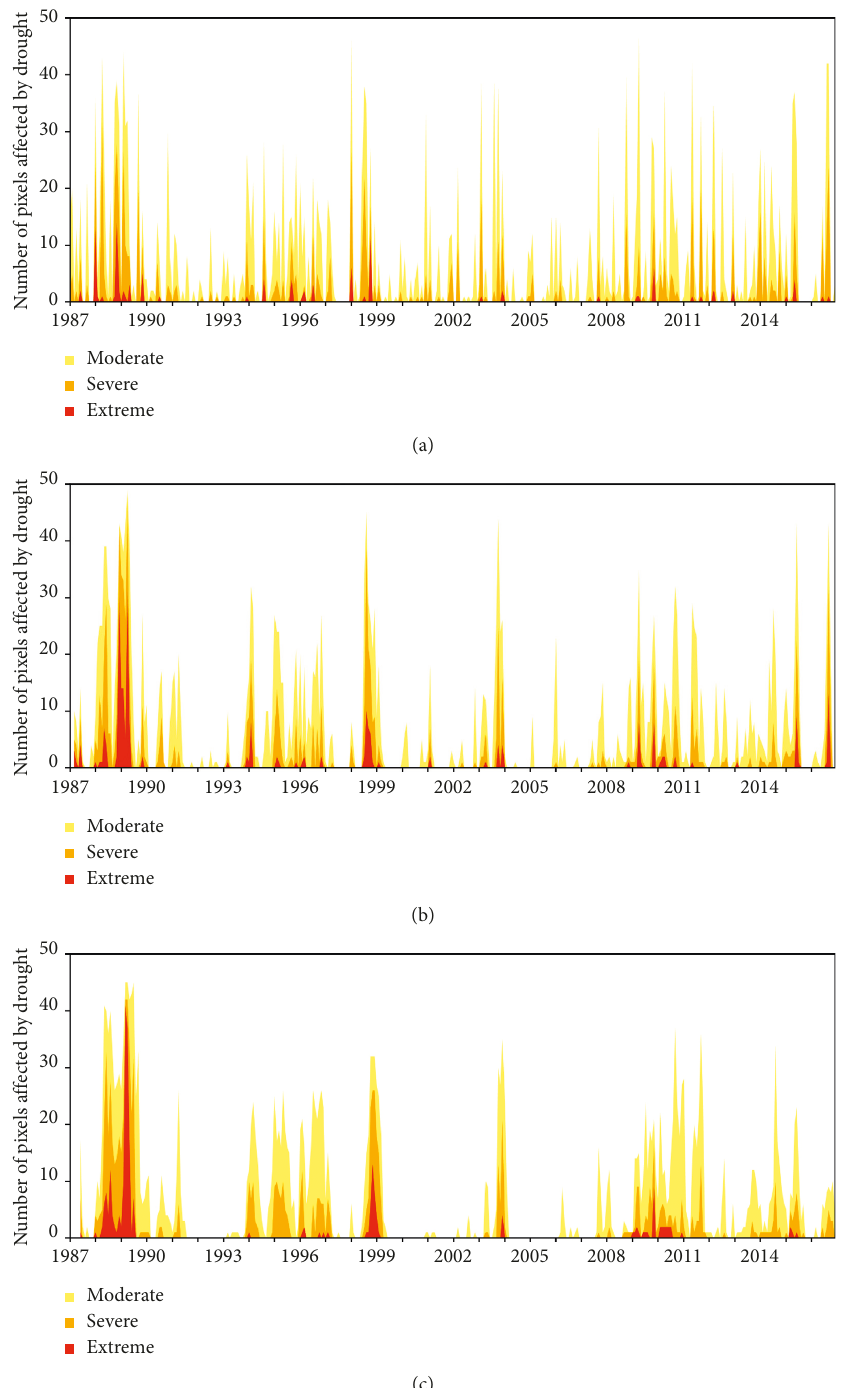
Figure 8: Temporal evolution of the number of pixels affected by dry conditions for the different dry categories and SPI timescales: (a) SPI1, (b) SPI3, and (c)